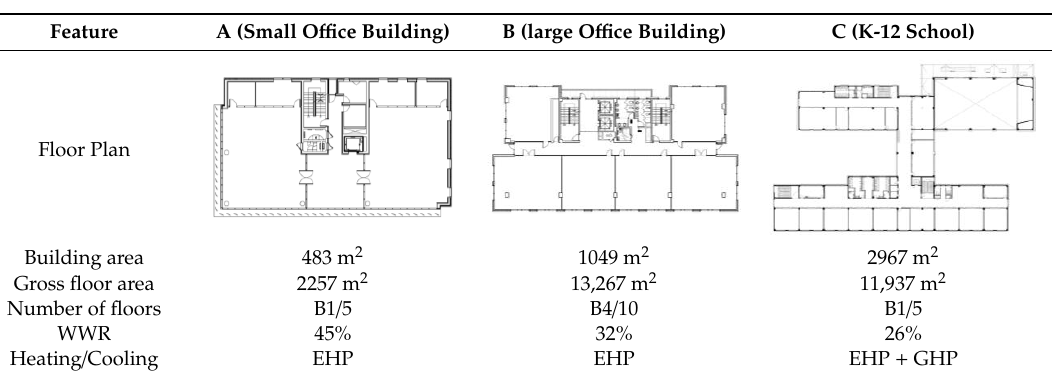
and LCC for the application of various ECMs have been calculated and their relationships to energy savings or PP have been analyzed. Table 5. Information on features of the selected reference buildings.